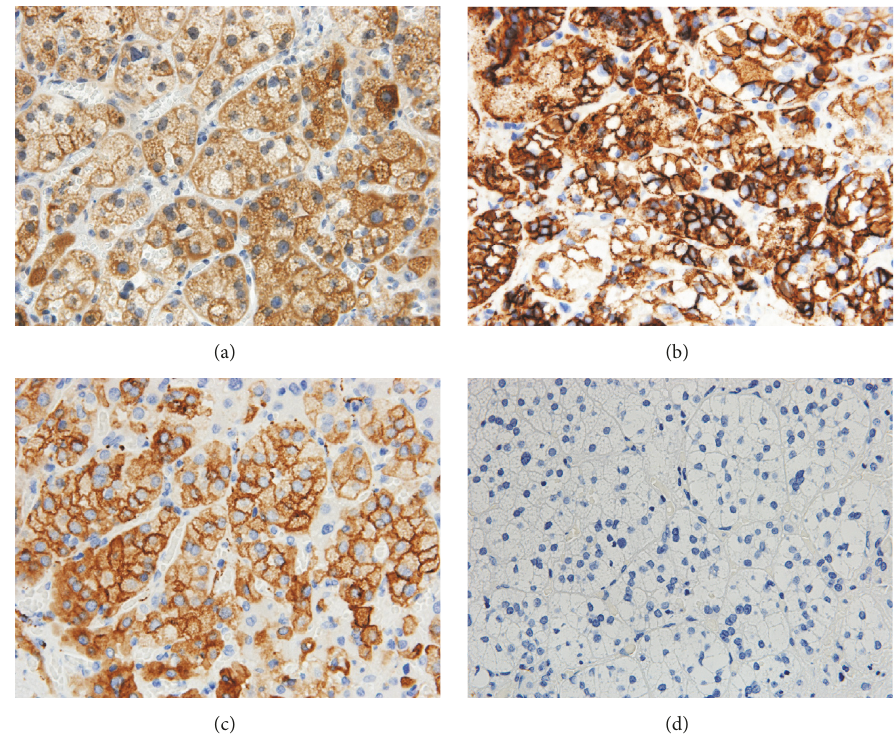
Figure 4: Immunohistochemical staining. Immunohistochemistry of the lesion. The cells are positive for inhibin 𝛼 (a), CD56 (b), and synaptophysin (c), whereas cells were negative for chromogranin A (d) (all photomicrographs ×